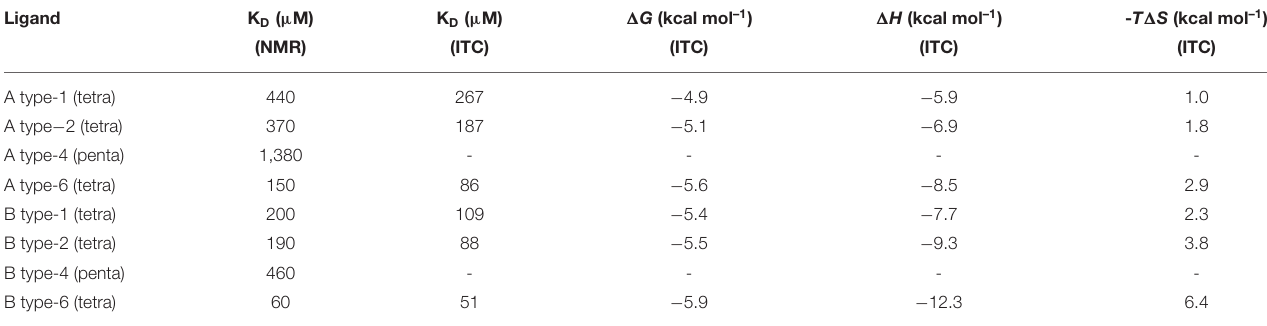
TABLE 1 | Equilibrium dissociation constants (K D ) determined for the interactions of the different A and B blood group antigens with Gal-4N by employing HSQC NMR-based titrations and ITC measurements, along with the thermodynamic parameters for the interactions, as determined by